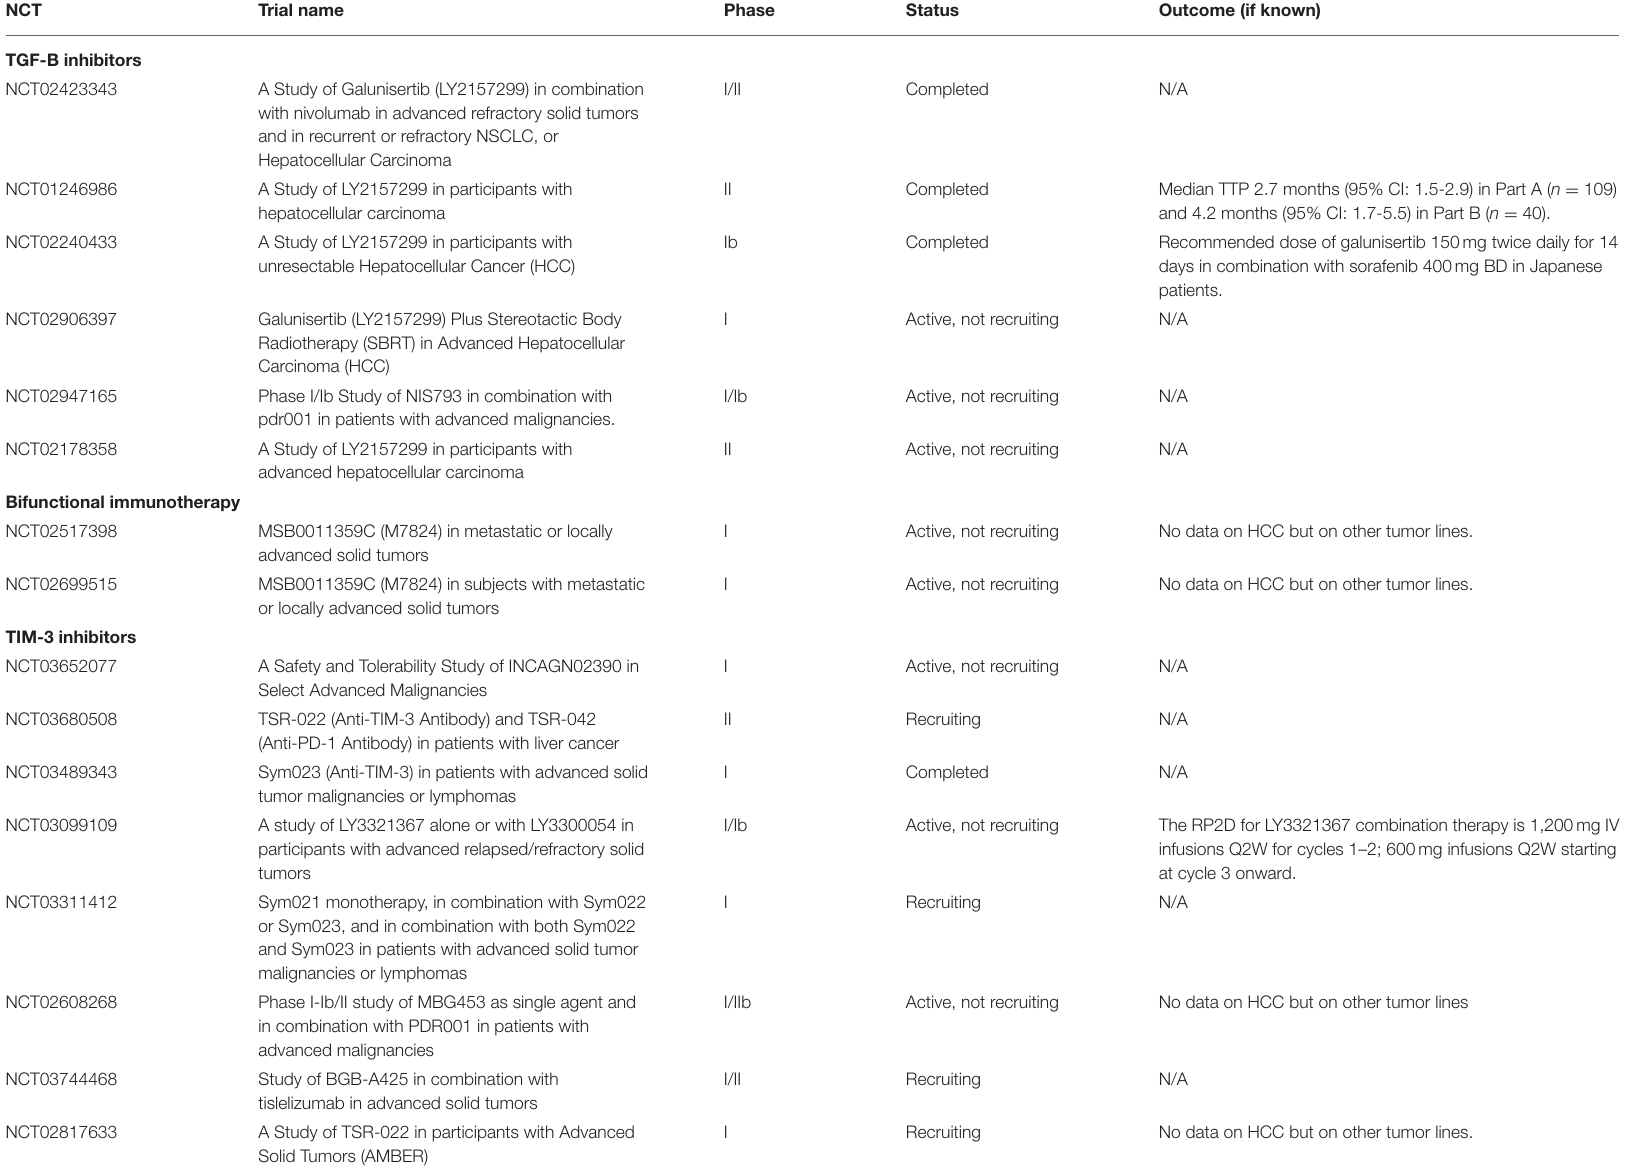
TABLE 2 | Novel targets for molecular therapies in hepatocellular